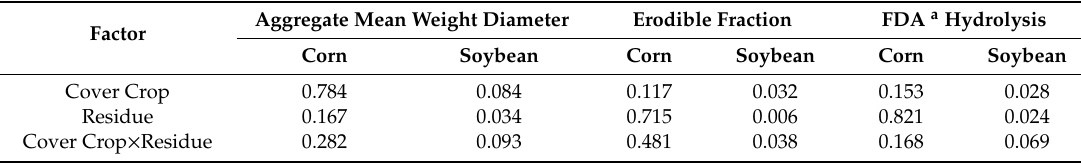
Table 1. Field study 2; probability (Pr < f ) of main effects and interactions of cover and residue management treatments on soil properties.